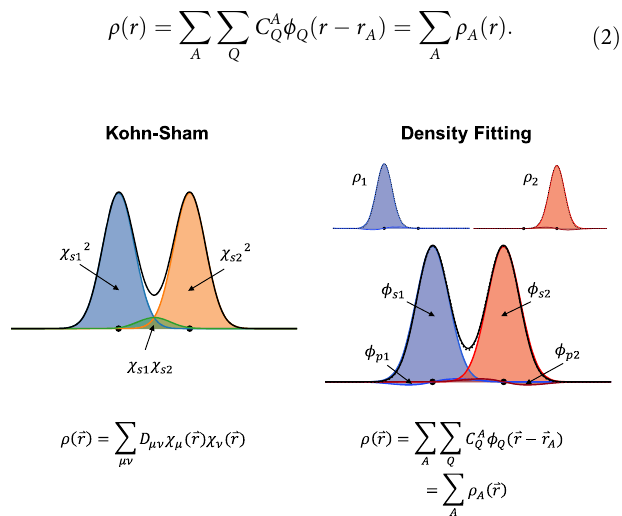
Fig. 1 Illustration of conventional and density- fi tting based basis expansions of the electron density. Left: In a conventional Kohn – Sham DFT calculation, the electron density (solid black line) is expanded in terms of density matrix elements D μν and products of basis functions χ μ χ ν . Right: Density- fi tting (DF) allows expanding the density in terms of fi tting coef fi cients C A Q and atom-centered basis functions ϕ Q (dotted black